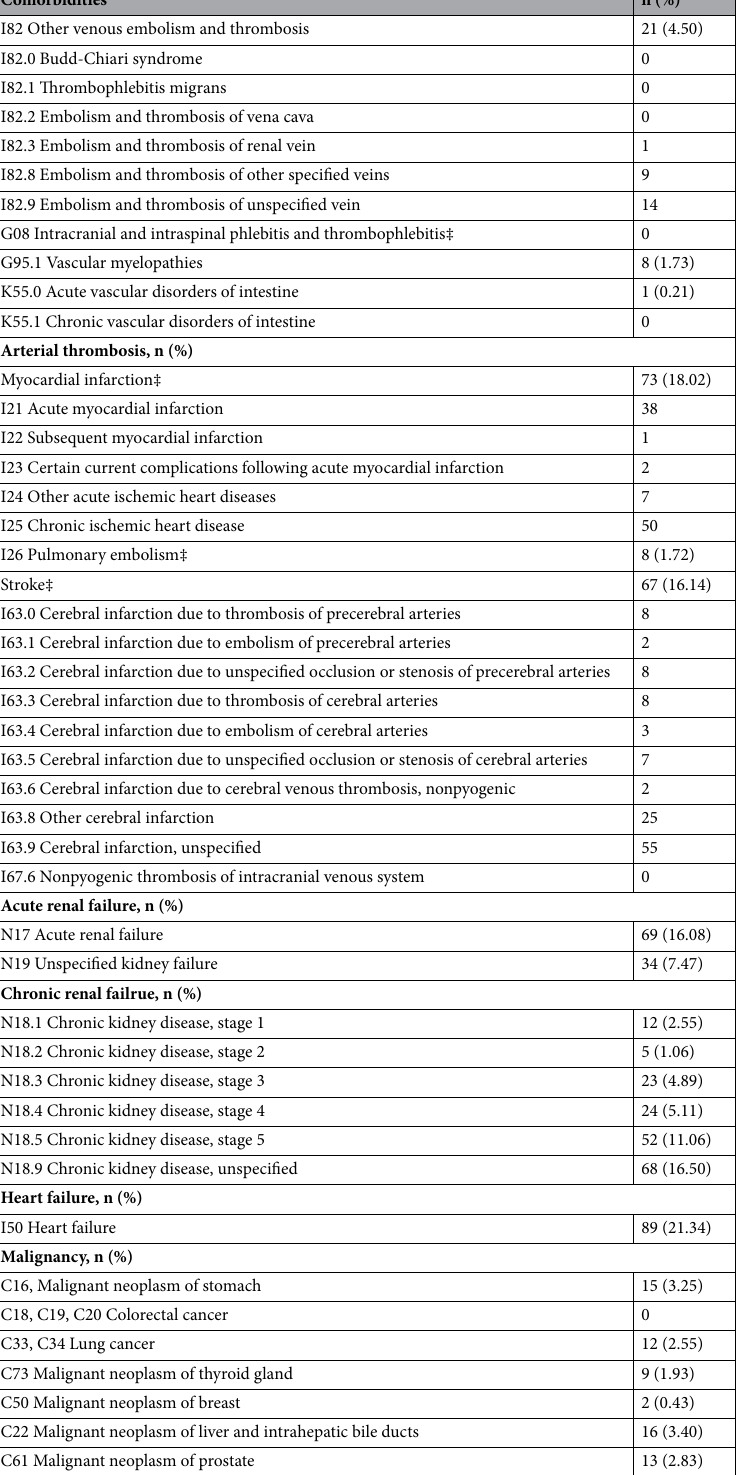
time of MGUS diagnosis. ‡ This entry includes all